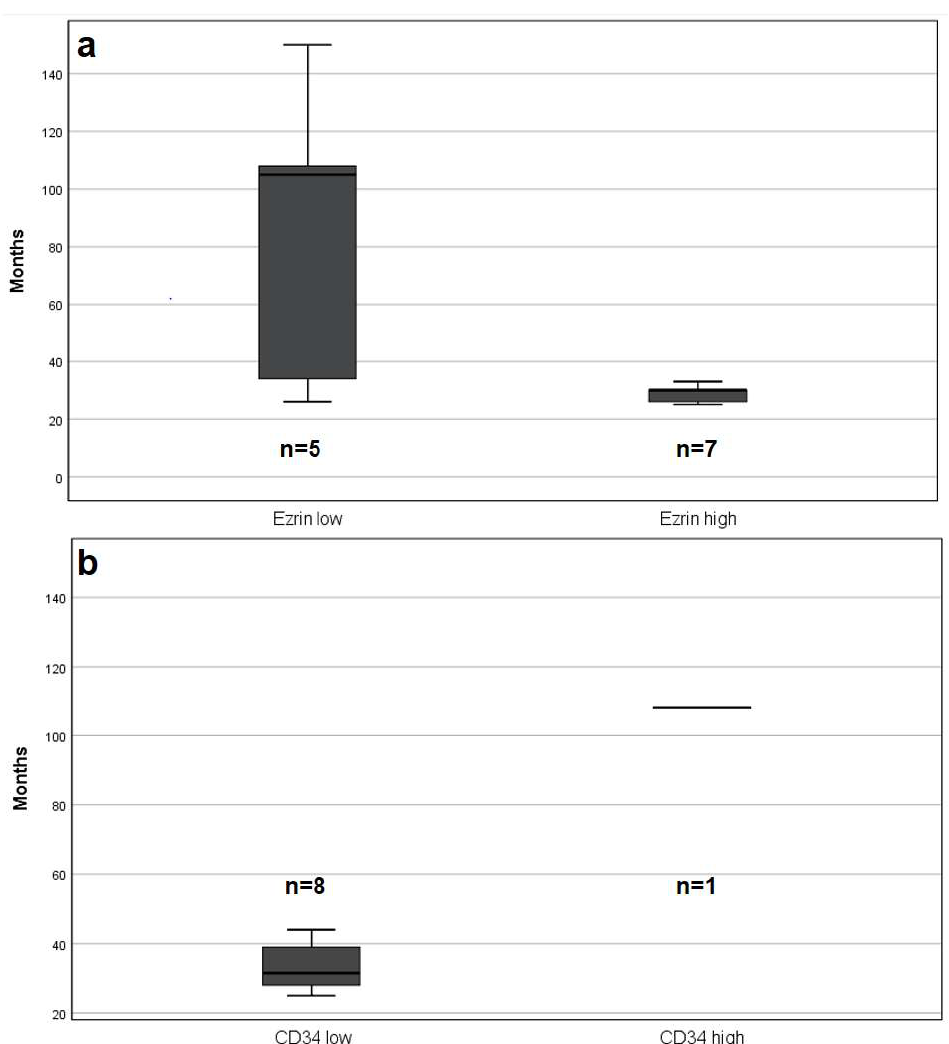
Figure 2. Box-plot graphs illustrating the time differences in months between primary diagnosis and death among patients with low and high Ezrin expression ( a ) as well as in patients with low and high capillary count through CD34 ( b ).